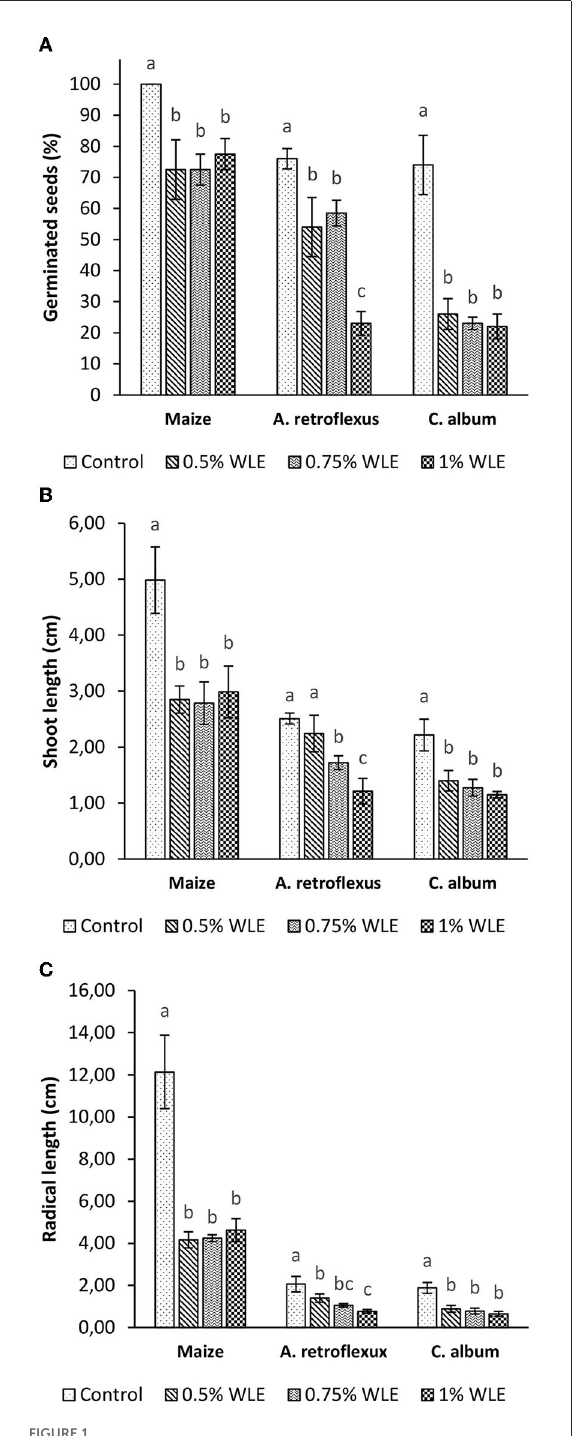
FIGURE1 Seed germination (A) , shoot growth (B) , and radical growth (C) of maize and weeds - Amaranthus retroflexus and Chenopodium album as a response to treatment with 0.5, 0.75, and 1% walnut leaf extract. Data are presented as mean ± SD. Values marked with different letters within a group differ significantly based on Fisher’s LSD test ( p ≤